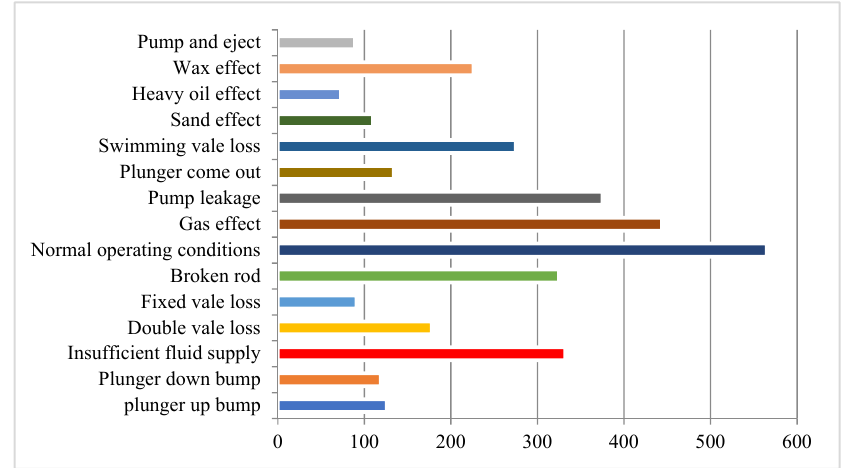
Figure 1. distribution diagram of actual working condition data. Figure 1. Distribution diagram of actual working condition